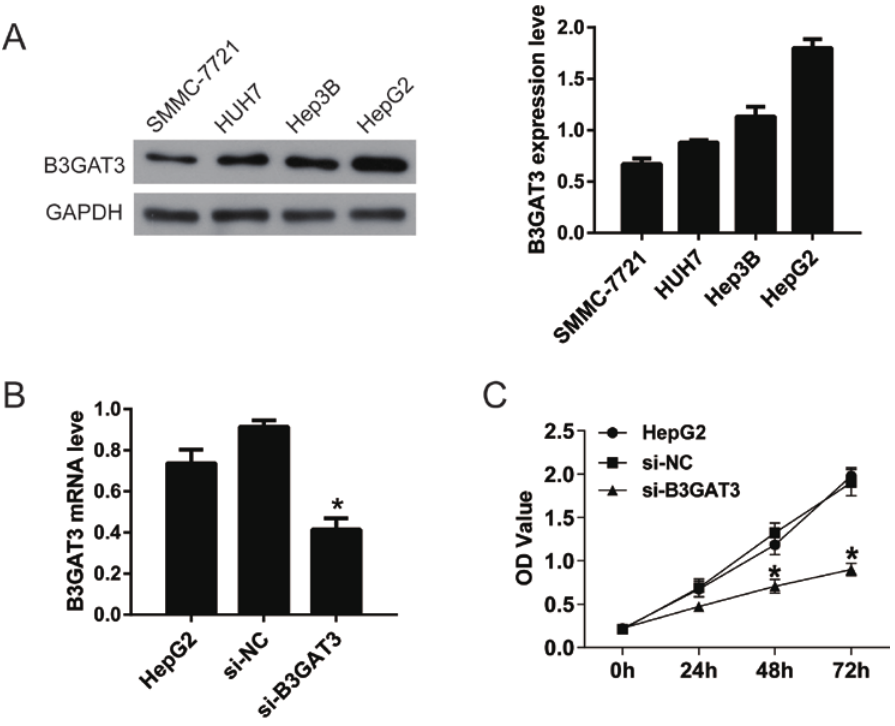
Figure 3: Knockdown of B3GAT3 inhibited the proliferation of liver cancer cells. (A) Western blot was performed to detect the expression of B3GAT3 in four liver cancer cell lines, SMMC-7721, HUH7, Hep3B, and HepG2. Statistical results showed that B3GAT3 expression was highest in HepG2 cells. (B) B3GAT3 was knocked down in HepG2 cells and its mRNA level was detected using qPCR. (C) The proliferation of HepG2 cells was determined by CCK8 assay. *P<0.05 compared with si-NC.